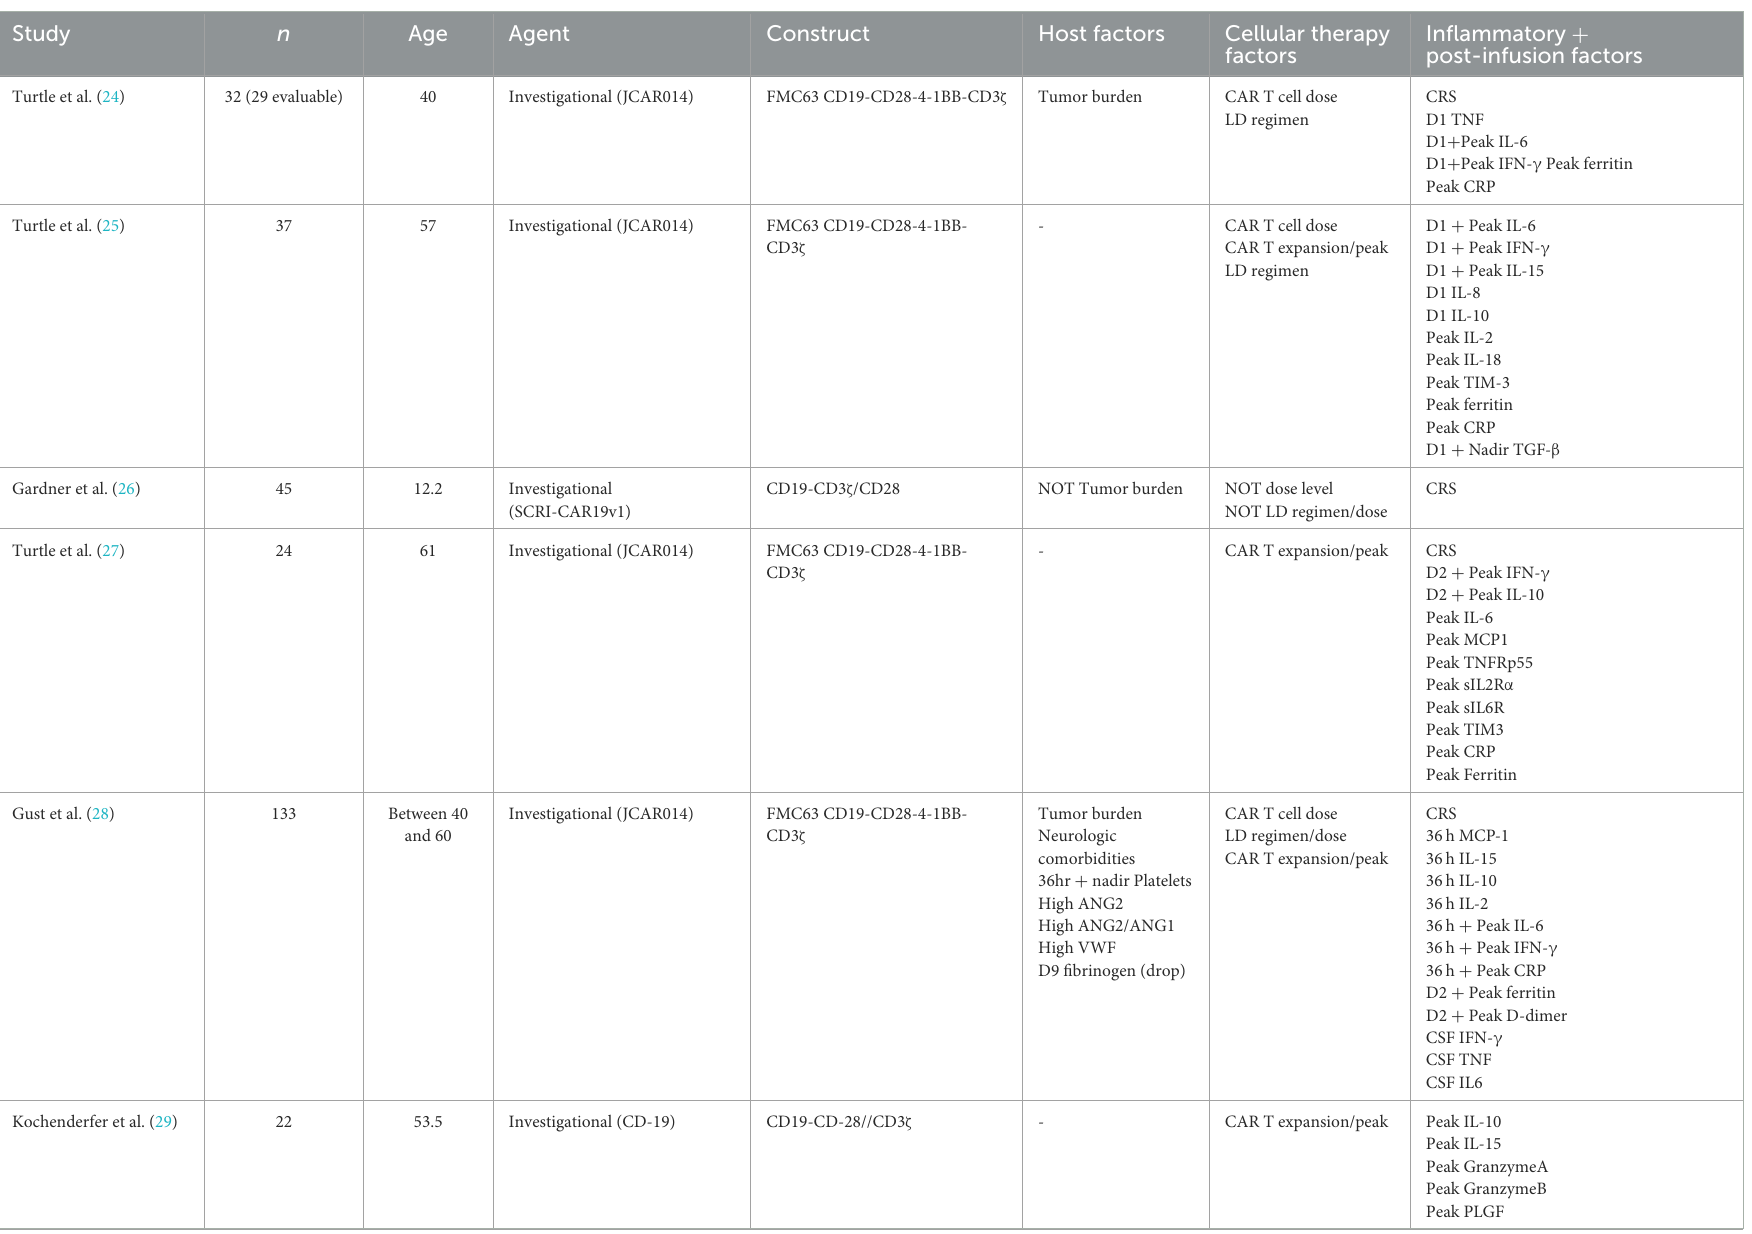
TABLE 2 Summary of predictive and associated neurotoxicity markers by